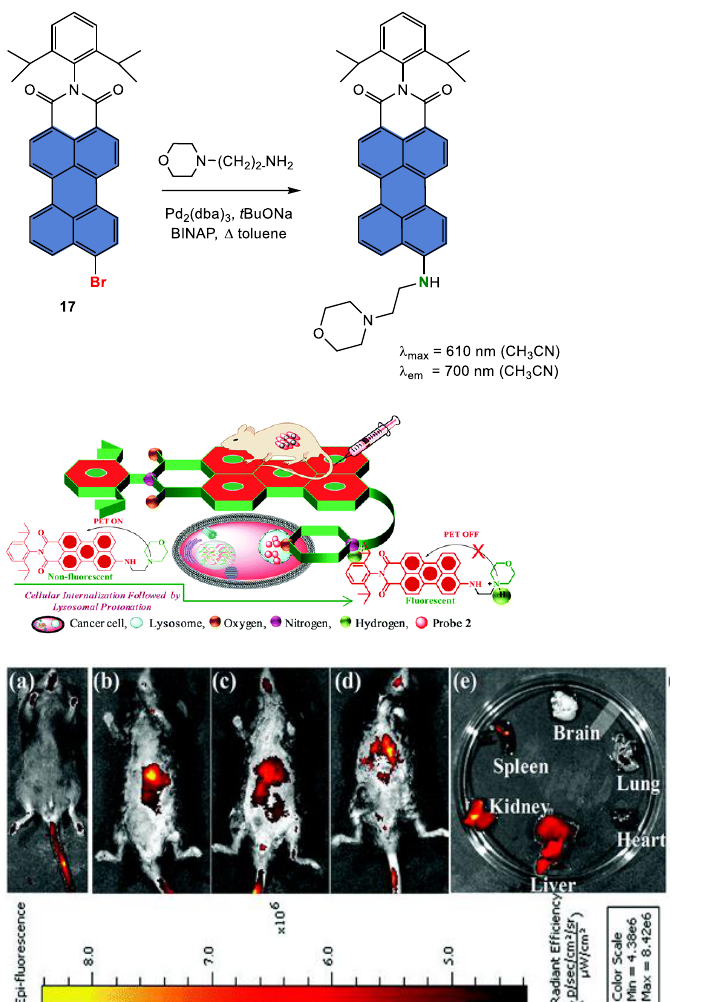
Figure 34. Synthesis and in vivo NIR imaging of PMI derivative in female C57BL/6J mice: ( a ) after 0 h, ( b ) 8 h, ( c ) 16 h, ( d ) 24 h, ( e ) ex vivo images of different organs after 24 h. Reprinted with permission from reference [152]. Copyright 2019 Royal Society of Chemistry.